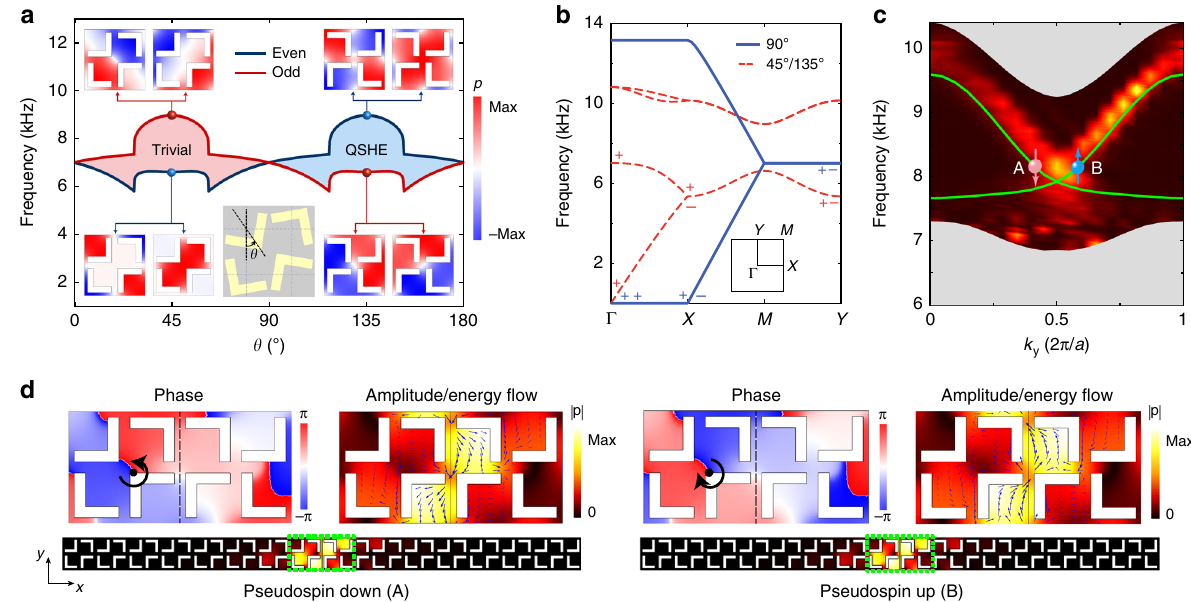
Fig. 5 Acoustic quantum spin Hall effect and helical edge states in the lowest band gap. a Evolution of the bulk bands and parities at the M point (including two doublets of even and odd parities) by tuning the rotation angle of the scatterers, θ (de fi ned in the inset). Acoustic pressure pro fi les of the doublets at the four marked points are shown as the insets. The parity inversion indicates that the blue region mimics the quantum spin Hall insulator in acoustic systems, while the red region corresponds to the trivial band gap. b Acoustic bands for θ = 90°, 45°, and 135°. The symbols + / − represent, respectively, the even/odd parity for the Γ , X, and Y points for the lowest two bands. c Measured (hot color) and calculated (green) dispersions of helical edge states in the lowest band gap at the boundary between two sonic crystals with different θ ’ s, 45°, and 135°. The gray regions denote the bulk bands. d Acoustic pressure pro fi les for two edge states marked by the red and blue dots in c , with amplitude (hot color), Poynting vectors (blue arrows) and phase pro fi les shown near the boundary (the green-box regions at the bottom panel). Geometry parameters (except for the rotation angle θ ) are the same as that in Fig.